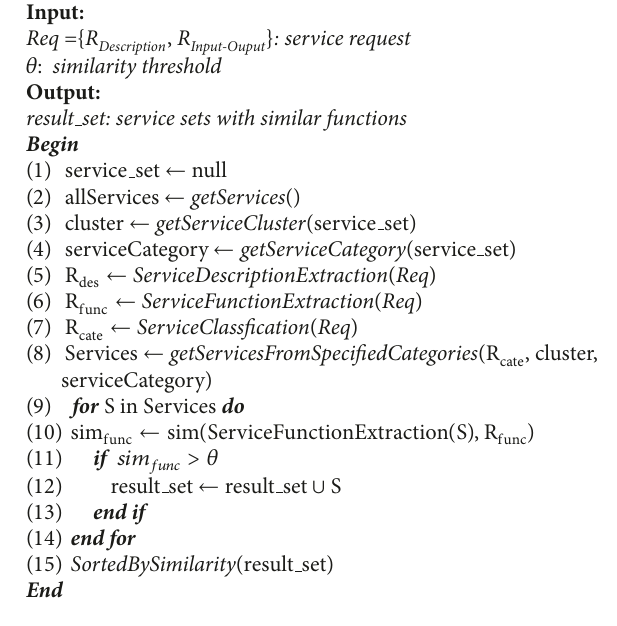
Algorithm 3: Semantic matching using mixed model of